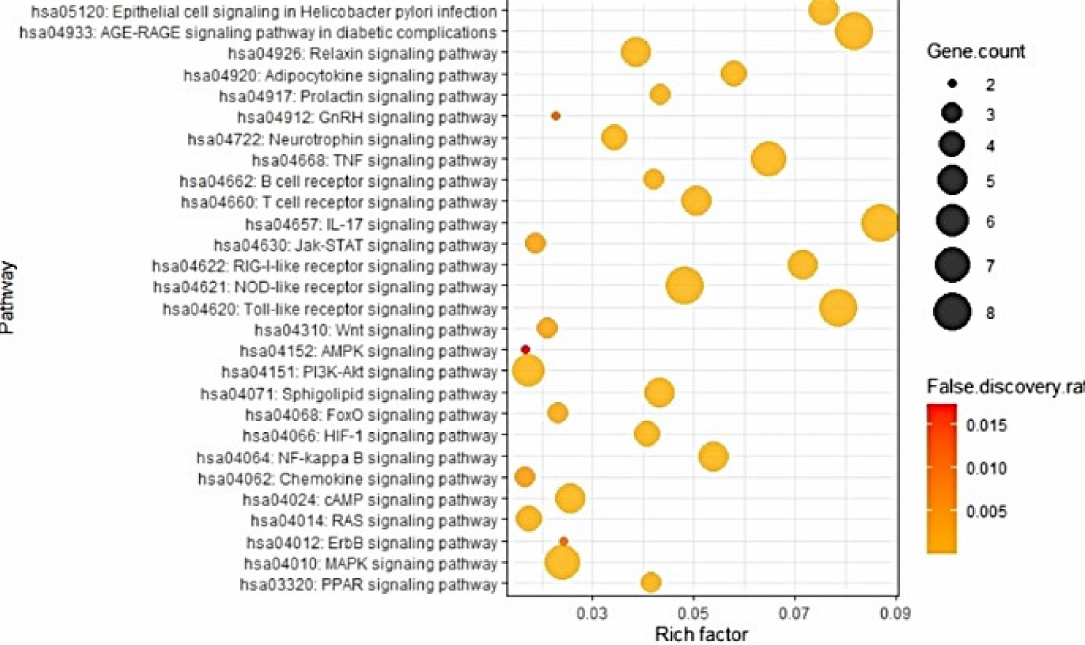
Figure 5. Bubble chart of 28 signaling pathways in PGCAM against